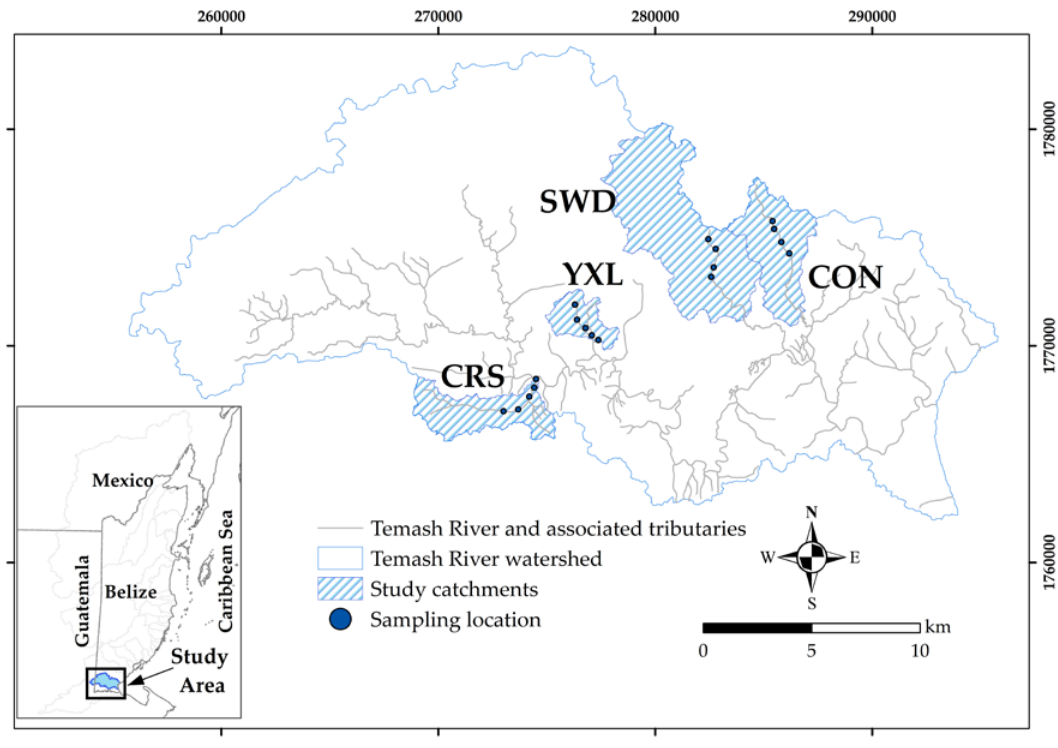
Figure 1. Locator map showing the study watershed (Temash River watershed) in southern Belize and the four catchments selected for in-stream nutrient monitoring-Crique Sarco (CRS), Yax Cal (YXL), Sunday Wood (SWD), and Conejo (CON). Coordinate system is Universal Transverse Mercator (UTM).